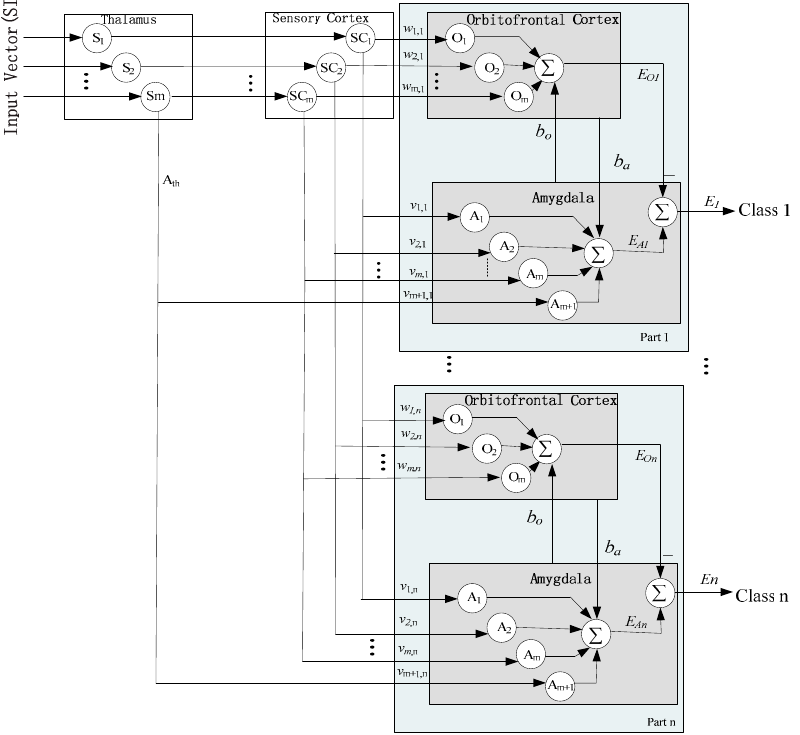
Figure 4. Improved multiple-output BEL network